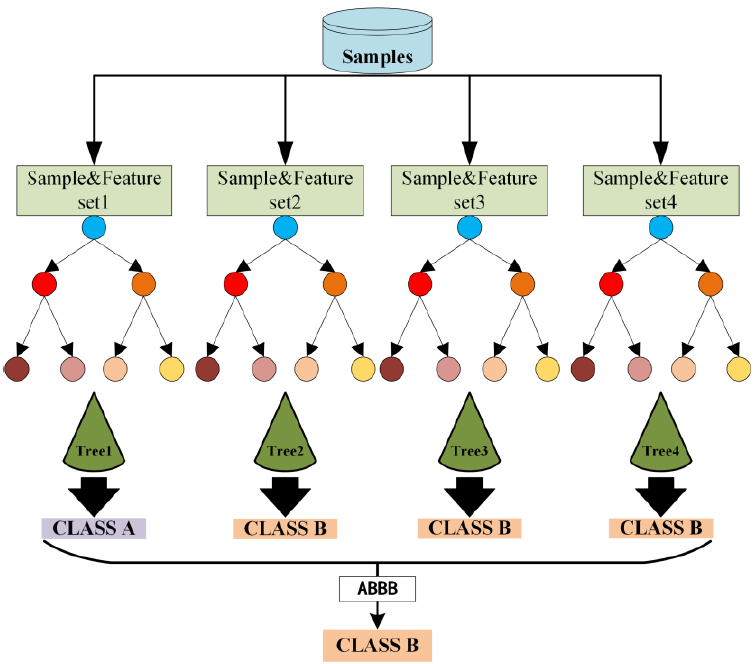
Figure 3. Random forest algorithm. Sub − datasets are generated from the dataset by random selection. The sub − datasets are fed into several decision trees that output the classification results, respectively. The final result was obtained using the majority rule.